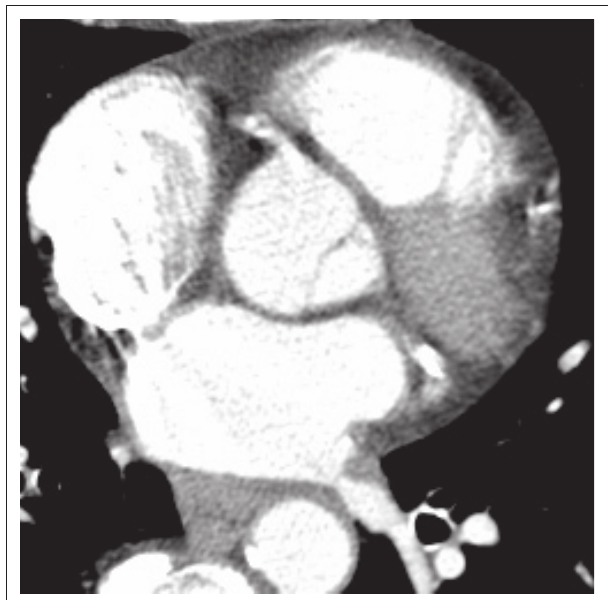
FIGURE 7: CTA shows significant narrowing of the ostium of the left inferior pulmonary vein, a complication of ostial ablation